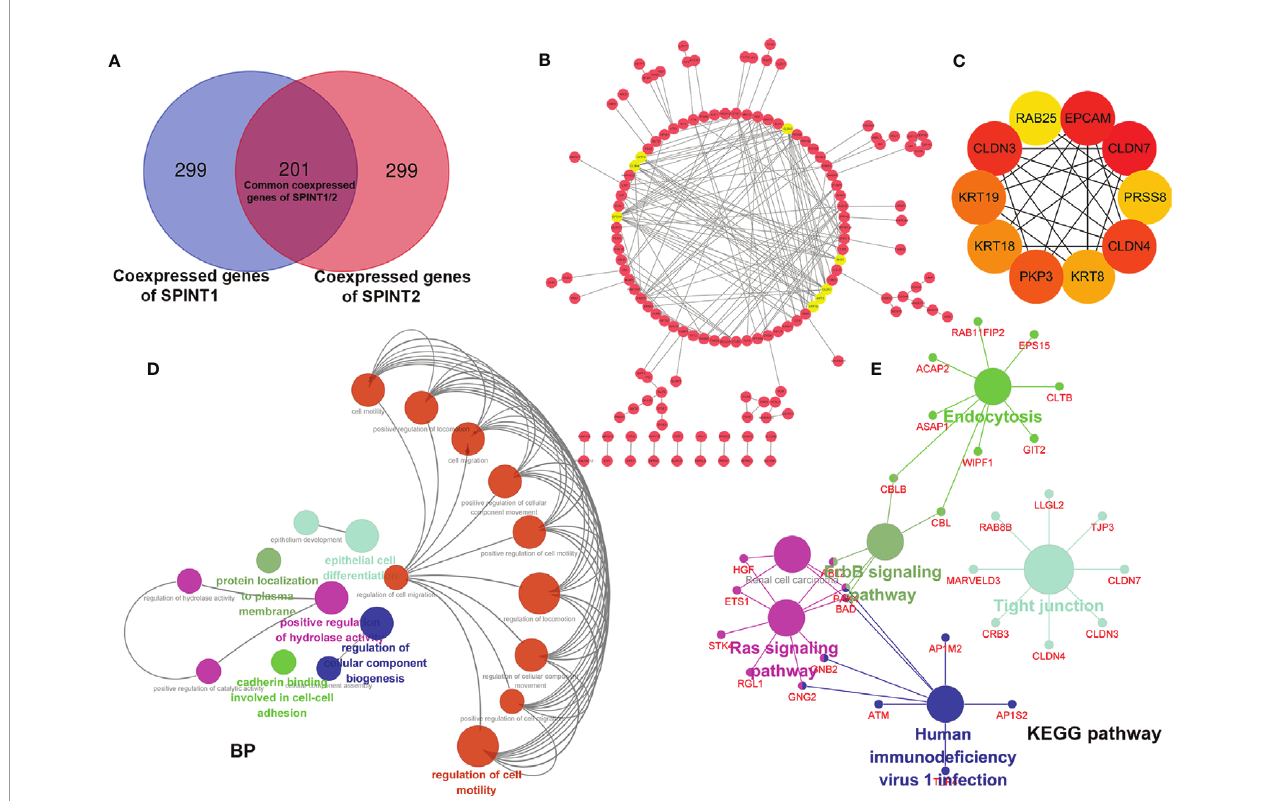
FIGURE 8 | Enrichment analysis and PPI network construction of SPINT1/2 common co-expressed genes with Cytoscape. Cross-reference of respective top 500 co-expressed genes of SPINT1/2 (A) , PPI network of SPINT1/2 common co-expressed genes (B) and hub genes (C) in the PPI network. BP terms (D) and KEGG pathways (E) enriched of SPINT1/2 common co-expressed